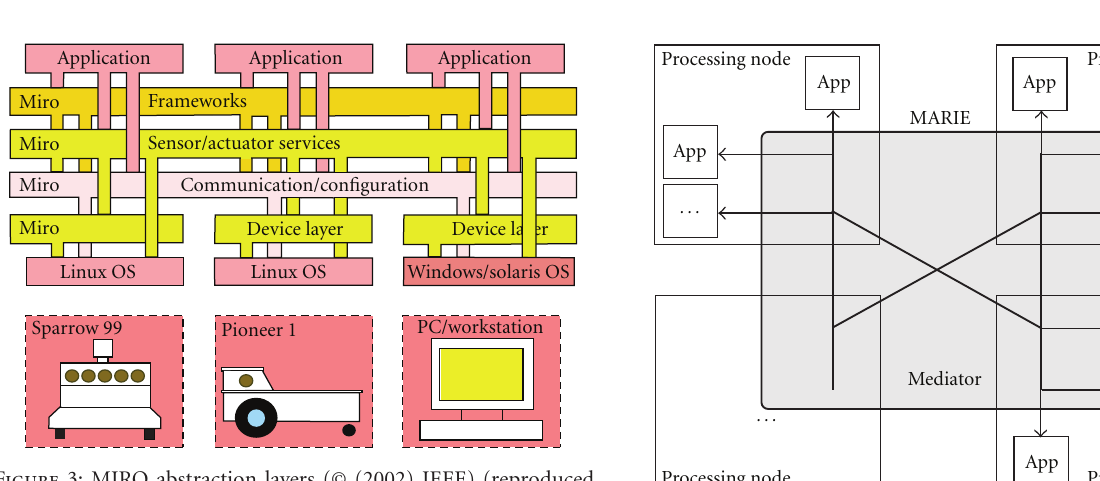
Figure 2: The CLARAty Architecture (© (2006) International Journal of Advanced Robotic Systems) (reproduced from [7] with permission of Dr. Issa Nesnas).